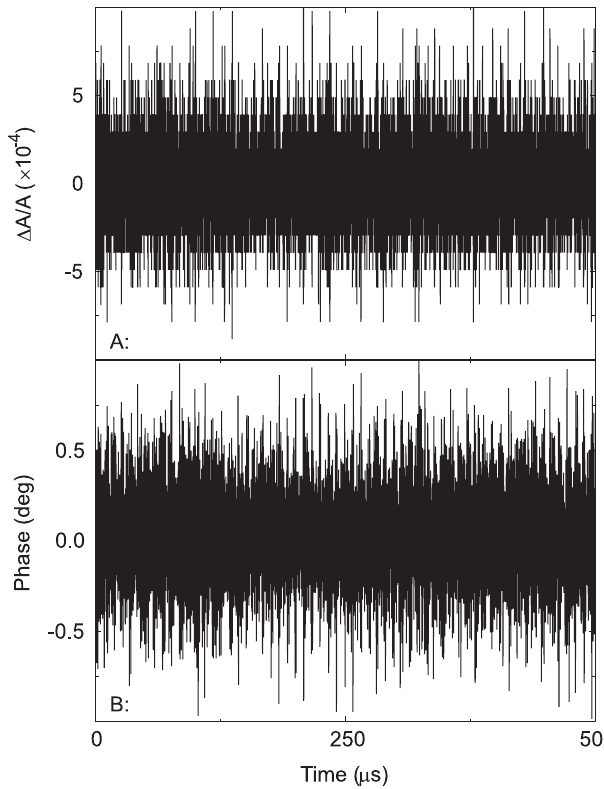
FIG. 9. Amplitude ( A ) and phase ( B ) error of the digital control system with an integral controller in the phase